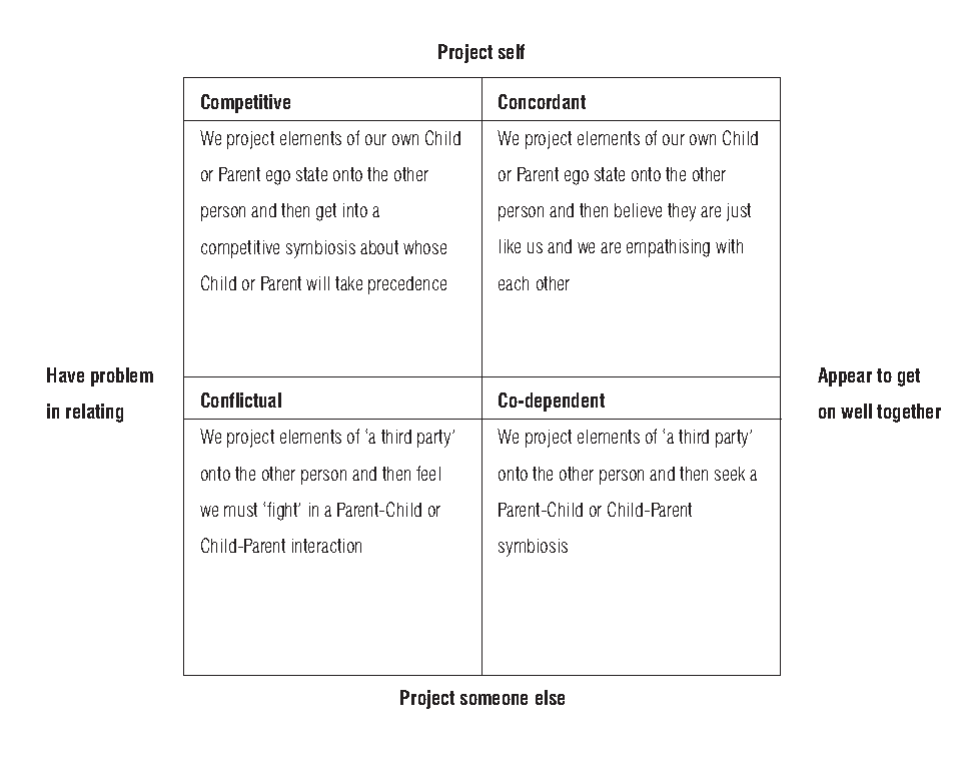
Figure 30: Transference Formats (Hay, 2007 p. 16)